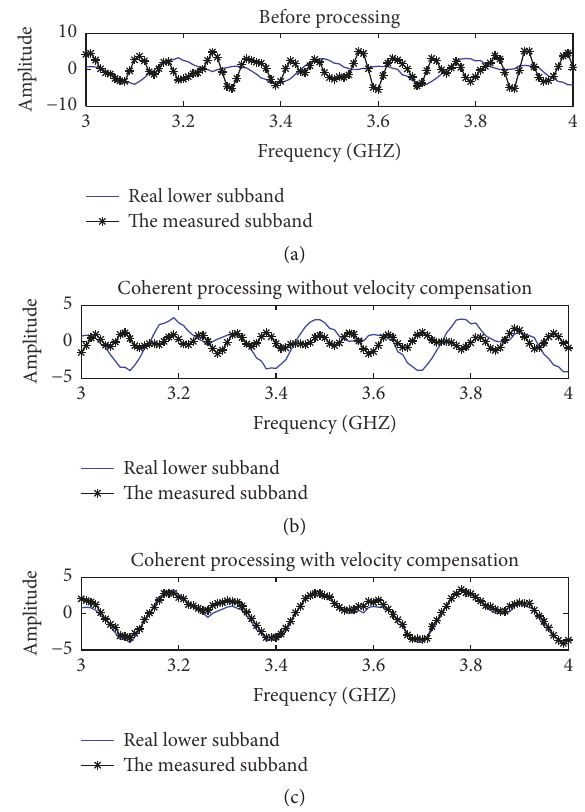
Figure 5: Comparison between real lower subband and the mea- sured subband ((a) shows the two subbands before processing, (b) shows velocity compensation is not used to process the measured subband, and (c) shows velocity compensation is used to process the measured